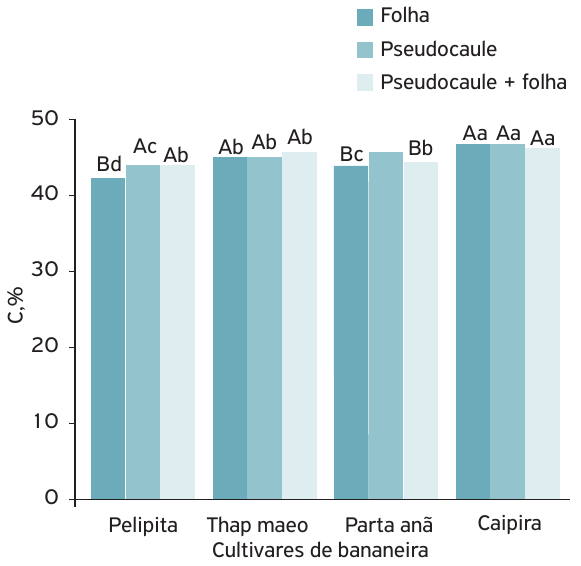
Figura 9. Teores de C, %, presente no substrato à base de resíduos de bananeira (pseudocaule, folha e pseudocaule + folha) de quatro cultivares de bananeira (Thap maeo, Prata anã, Pelipita e Caipira) após 49 dias de colonização pela linhagem 09/100 de Pleurotus ostreatus . Letras maiúsculas comparam médias dentro de um mesmo cultivar de bananeira; letras minúsculas comparam médias dentro de cada tipo de resíduo.